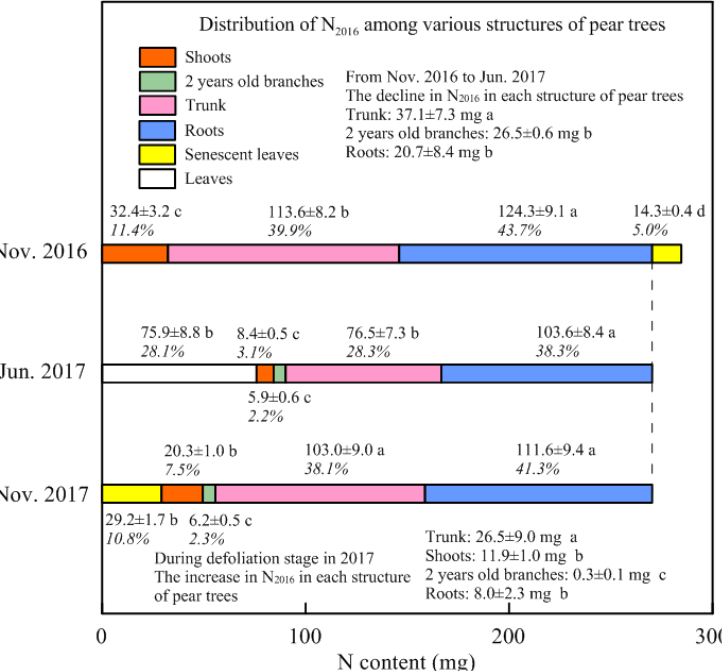
Figure 2. The distribution of N 2016 among various structures of pear trees. N 2016 means amount of fertilizer-N derived in 2016. The numbers means the N 2016 amount in each structure. Different small letters for each sampling time indicate significant differences ( p < 0.05) among organs. The italic numbers mean the ratio of N 2016 in each structure to total N 2016 in a whole tree.